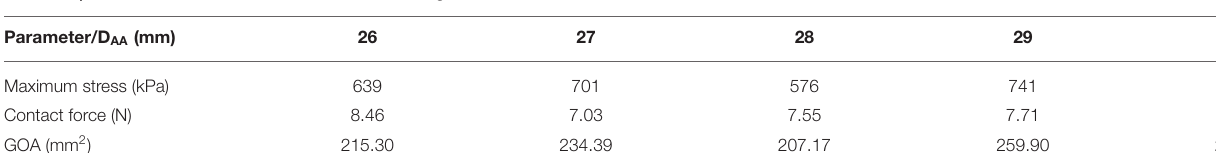
TABLE 3 | Parameter values of the model with a valve height of 14.5mm.